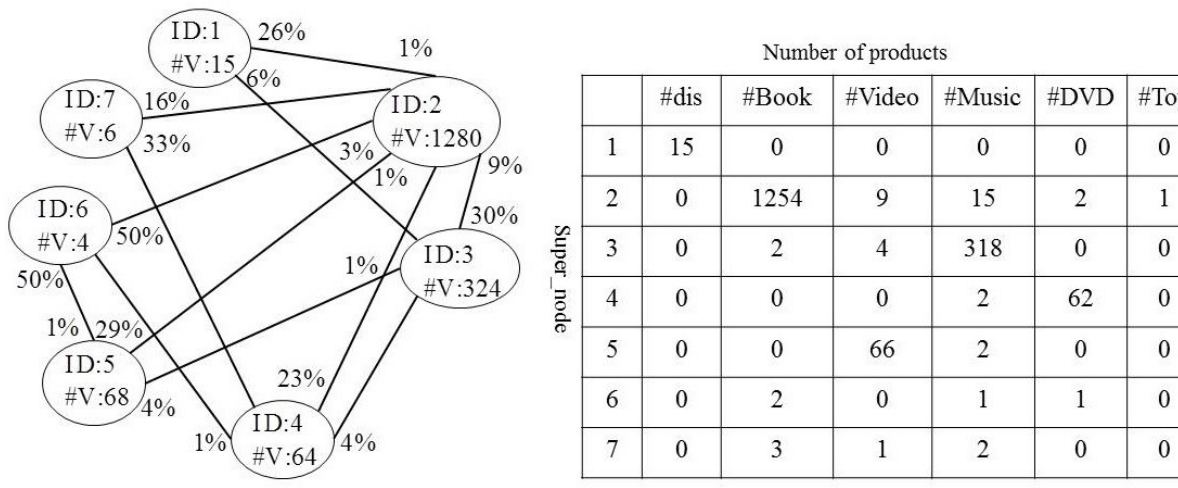
Figure 9: The fifth summary graph of the size of 7